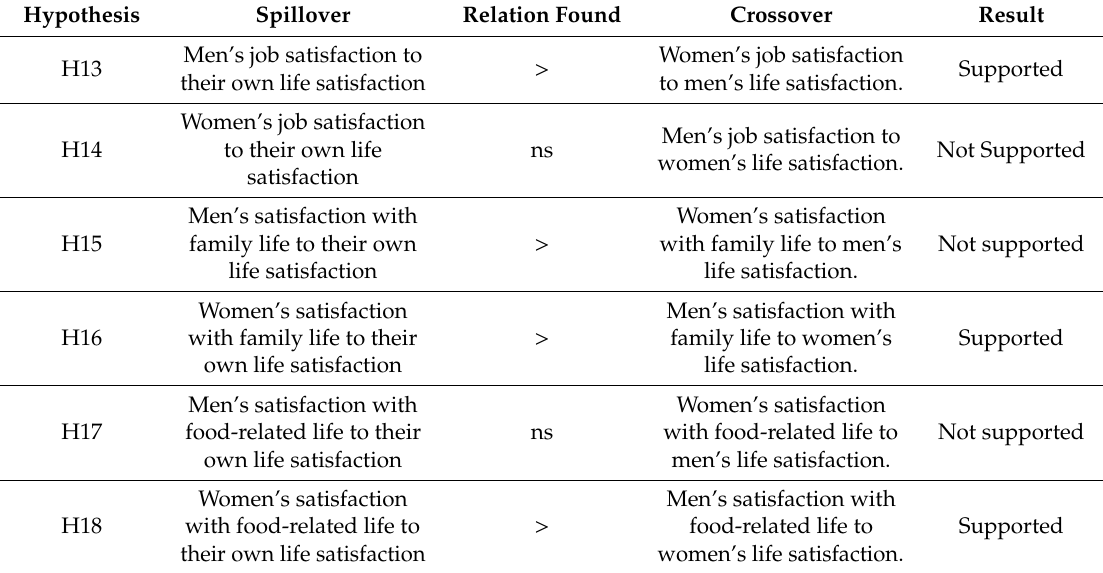
Table 3. Summary of hypotheses related to gender di ff